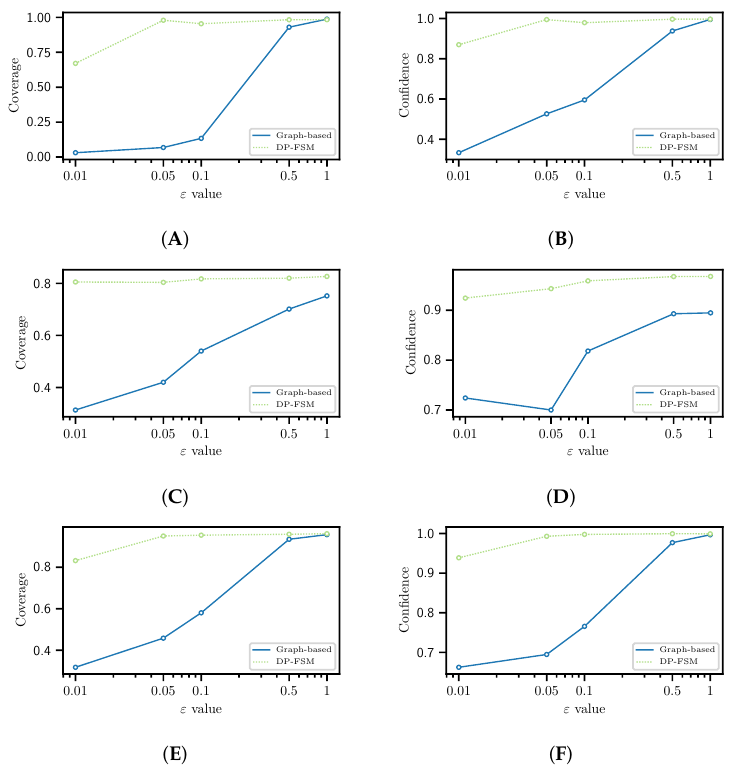
Figure 5. Coverage and confidence measures for the recommendations’ comparison between the graph-based and DP-FSM algorithms. Where ( A ) Coverage Bank, ( B ) Confidence Bank, ( C ) Coverage German, ( D ) Confidence German, ( E ) Coverage NYC, and ( F ) Confidence